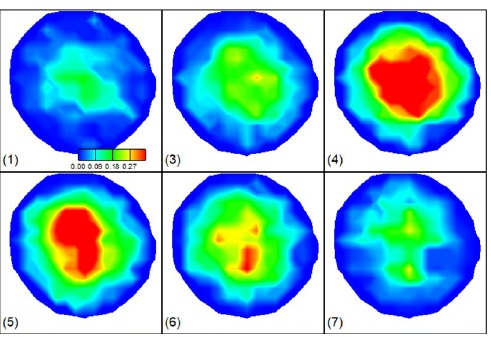
Figure 10. MRA-measured velocity magnitude contours on Slice 1 of the vertebral artery at 7 representative time points in a cardiac cycle. (4) corresponds the peak systole of the